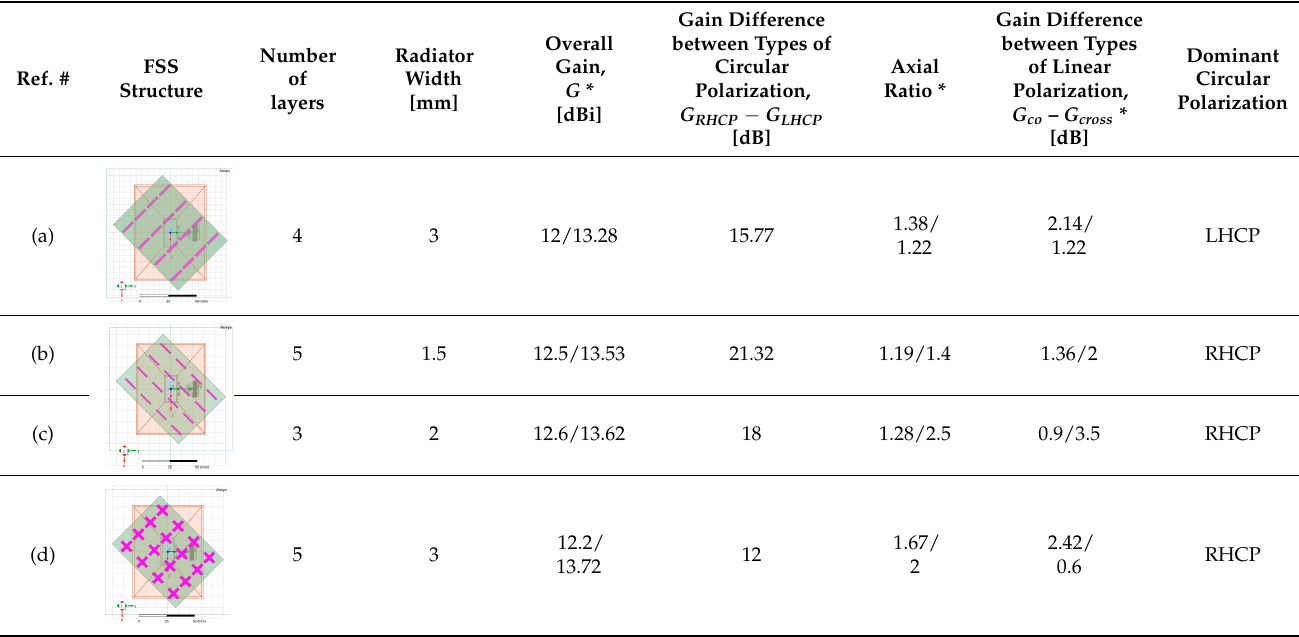
Table 4. Simulated and measured results for the four radiating systems with multi-layer FSS